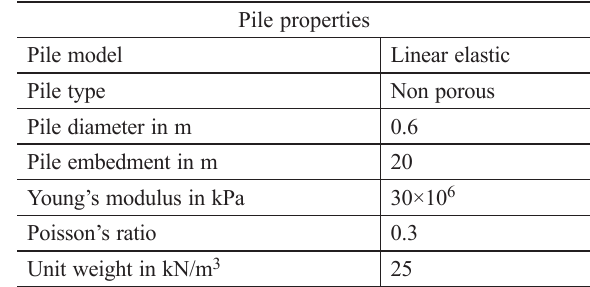
Table 1. Material properties of the sand layer Soil properties